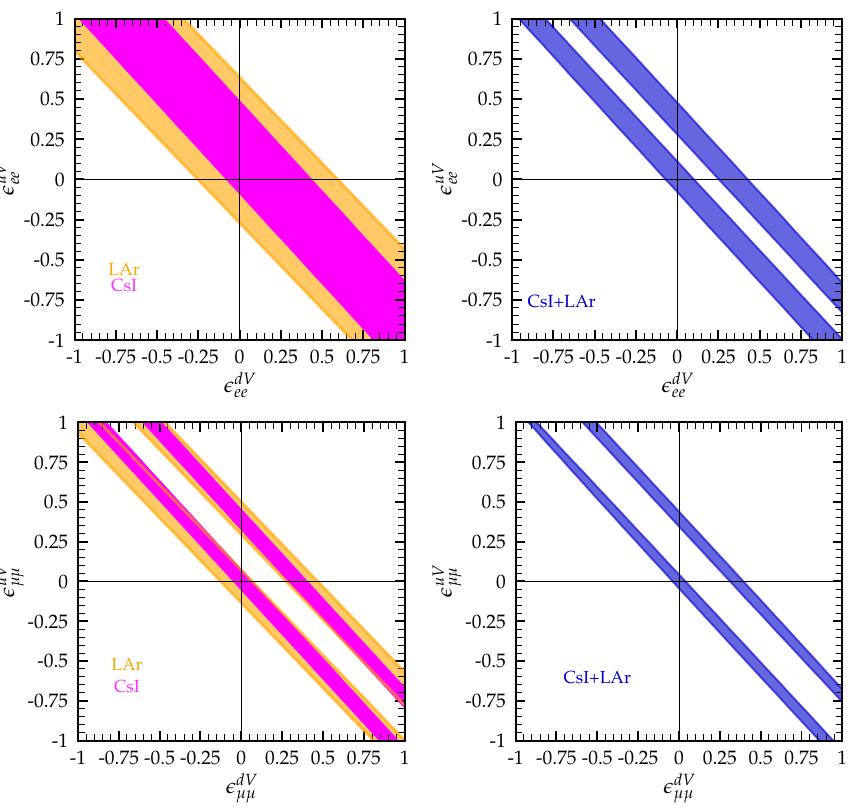
Figure 3 . 90% C.L. (2 d.o.f.) allowed regions on flavor-preserving neutrino NSI from the CsI (magenta), LAr (orange) and CsI + LAr (blue) analyses, allowing two NSI parameters at a time. The analysis of CsI data includes only CE ν NS